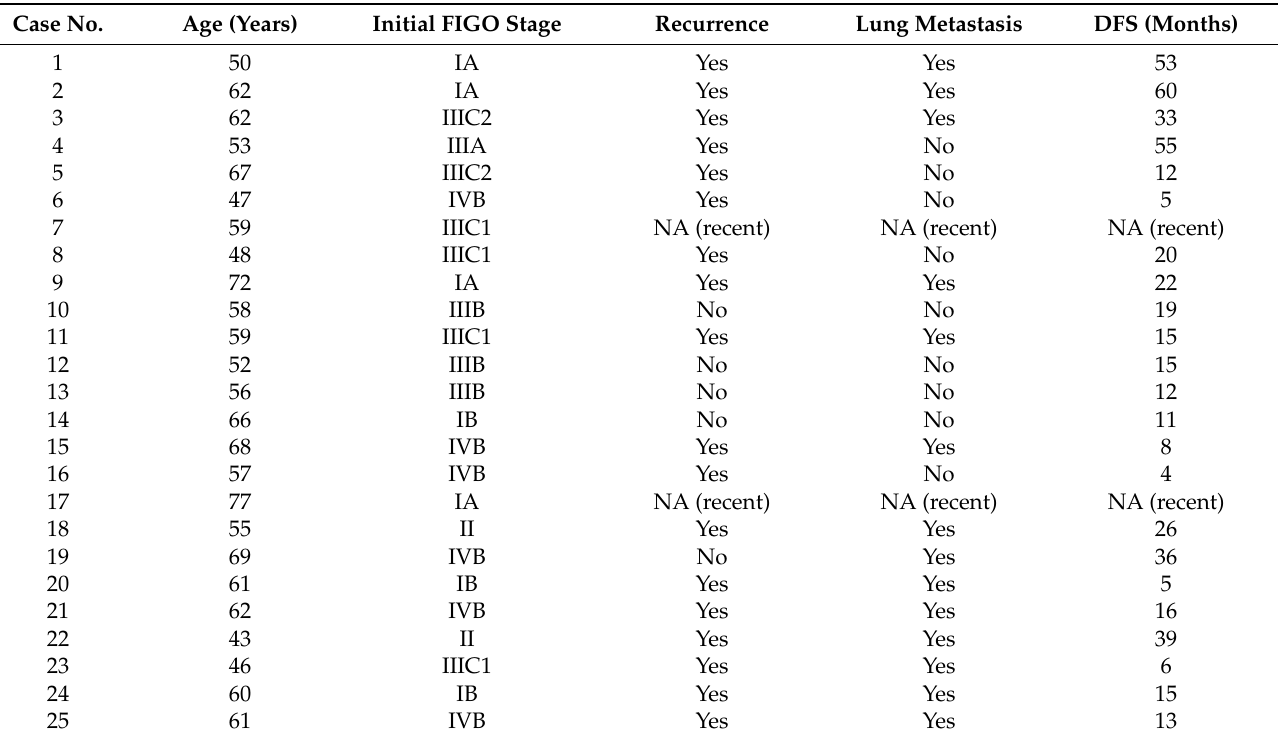
Table 2. Clinicopathological